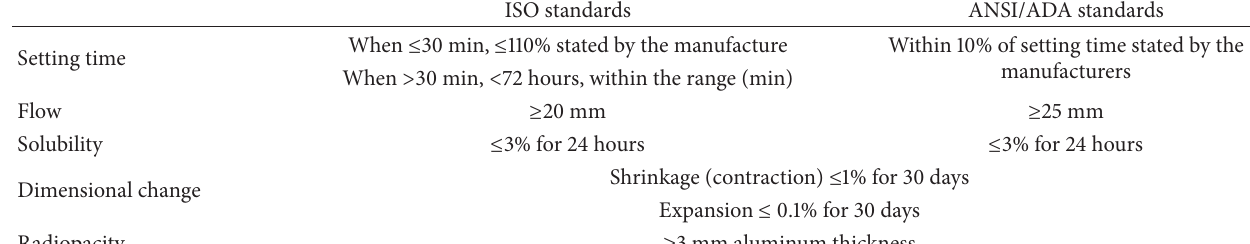
Table 1: ISO 6876/2012 and ANSI/ADA specification number 57 standards.